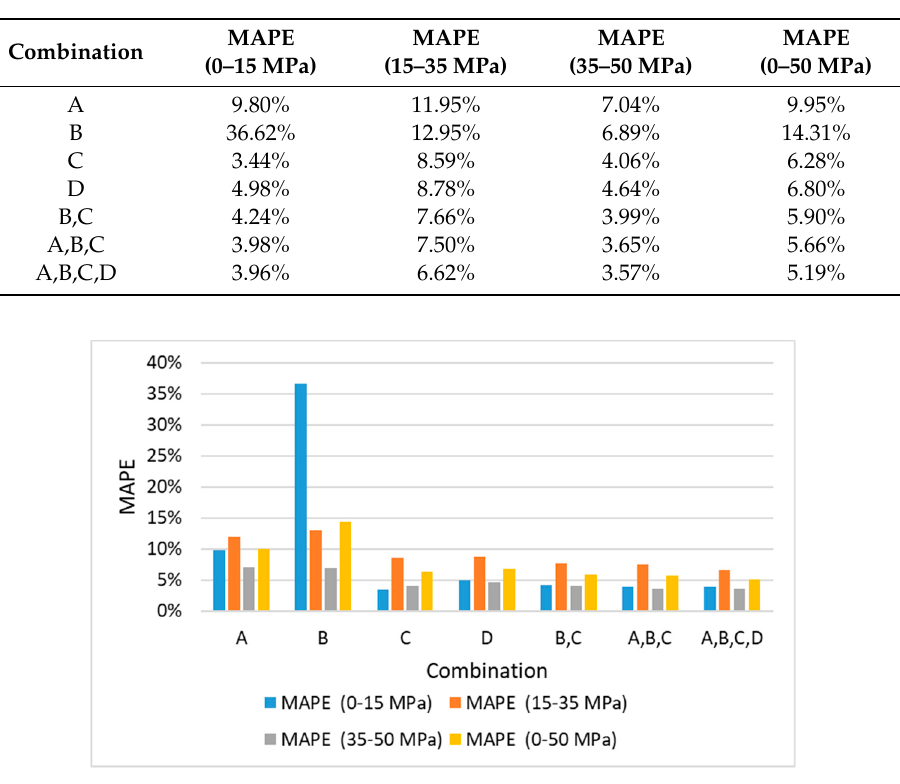
Figure 18. MAPE values for each section of fc predicted using the ensemble method.